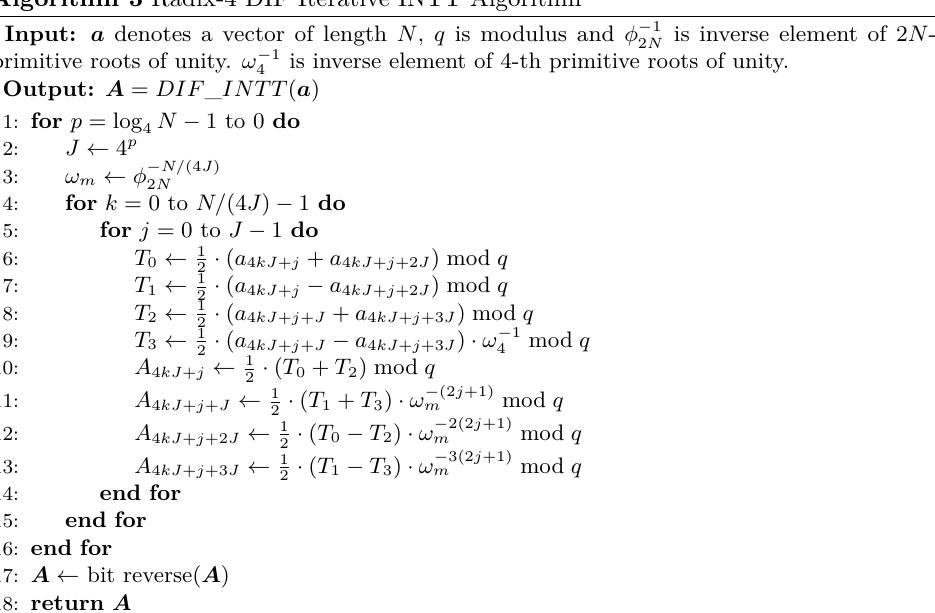
Algorithm 3 Radix-4 DIF Iterative INTT